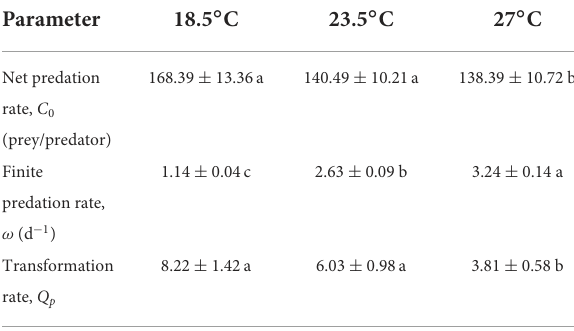
TABLE 6 Parameters of Orius strigicollis preying (Mean ± SE) on Frankliniella occidentalis at different